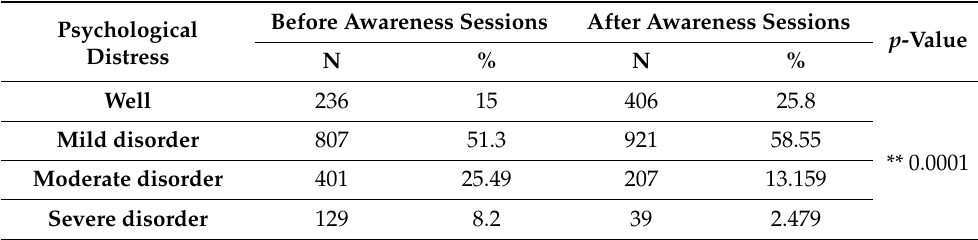
Table 5. Percentage distribution of staff nurses’ psychological distress during COVID-19 pandemic before and after awareness sessions ( n = 1573).